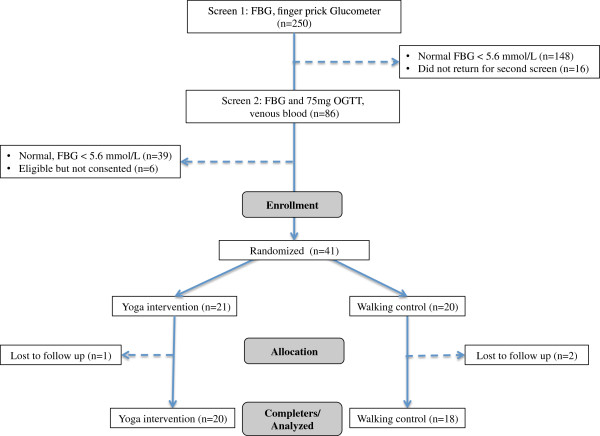
Flow diagram of study enrollment.